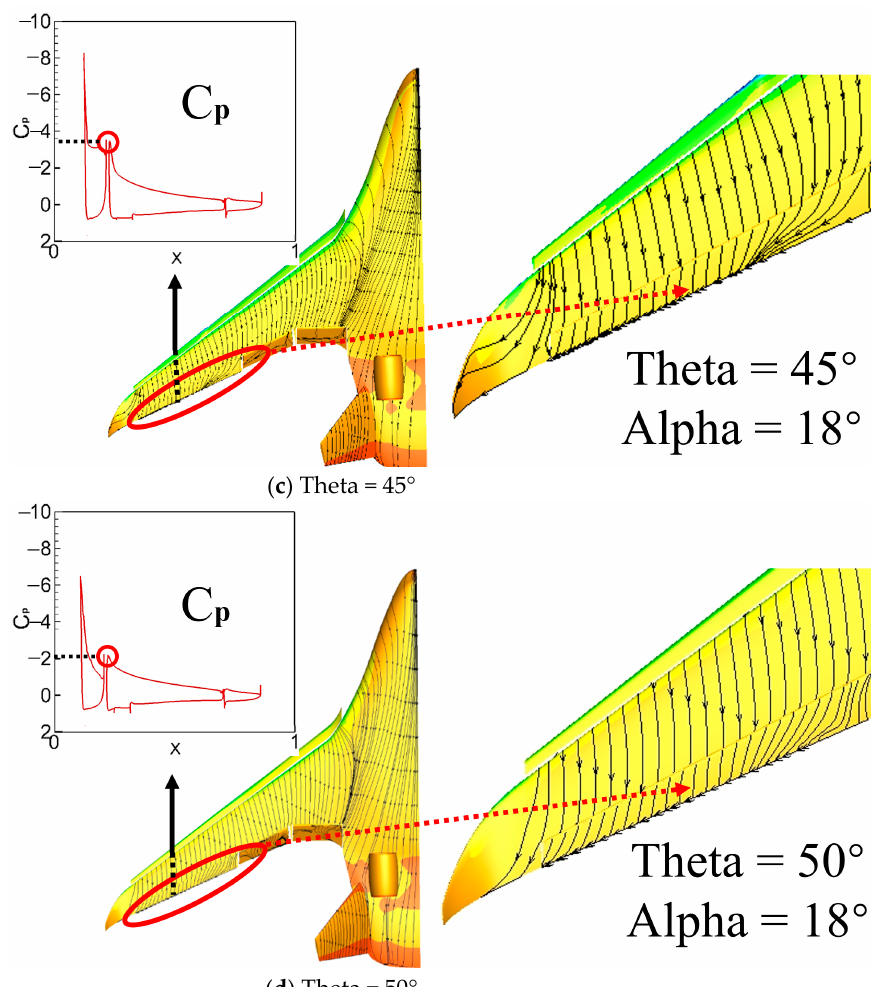
Figure 14. Upper surface limiting streamlines, the local pressure distribution of the sensitivity analysis of Theta.